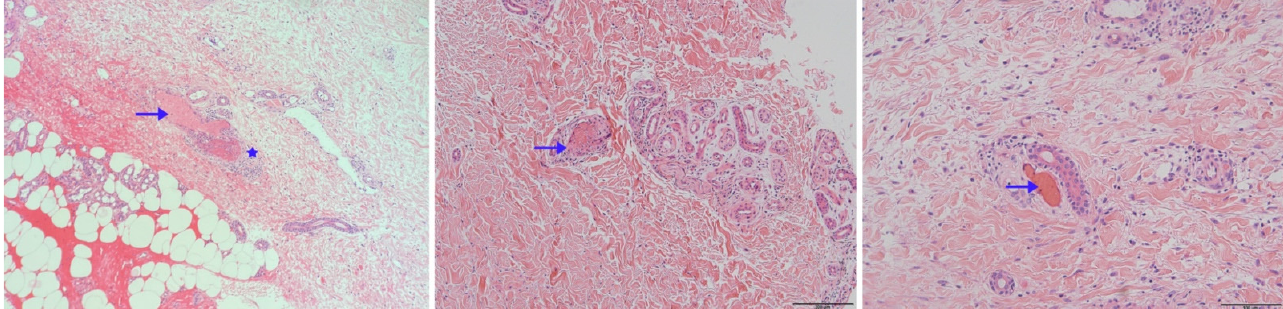
Figure 4. Skin biopsies of patients 1, 2 and 3. Table 1. The lab test results of the three patients.